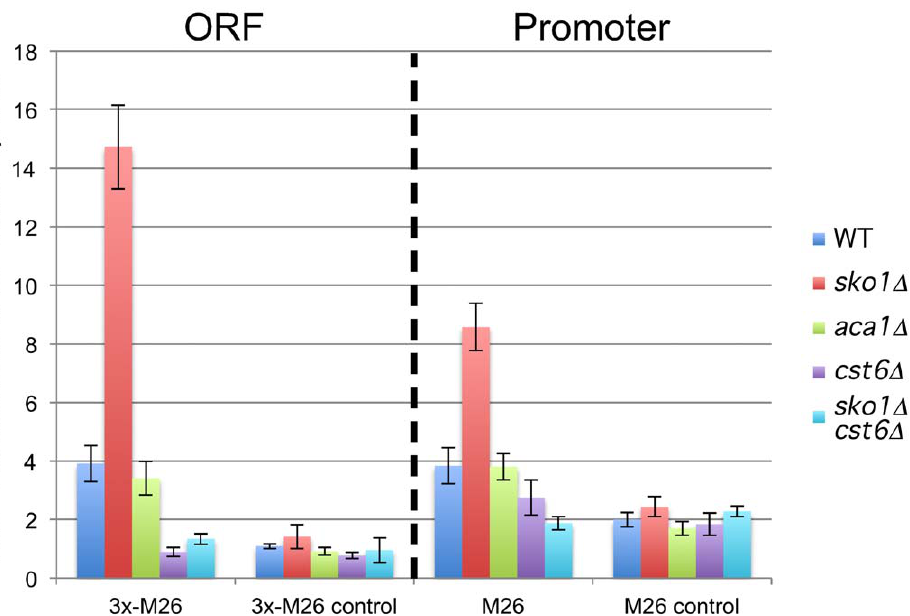
Figure 5. M26 hotspot is repressed by Sko1 and activated by Cst6. Strains containing the ade2-1003 allele and indicated transcription factor deletions were crossed to strains containing the same transcription factor deletions and the following ade2 alleles: 3x- M26 ( ade2-1008 ; ORF), 3x- M26 control ( ade2-1030 ; ORF), M26 ( ade2-1025 ; promoter), M26 control ( ade2-1026 ; promoter). Bars indicate the mean frequency of recombinants from at least three crosses. Error bars indicate one standard deviation. Transcription factor deletions are indicated by the format legend shown to the right. Crosses are from left to right: ( ade2-1008 6 ade2-1003 ) Wsc70 6 72, Wsc126 6 127, Wsc184 6 183, Wsc157 6 143, Wsc179 6 172; ( ade2-1030 6 ade2-1003 ): Wsc120 6 72, Wsc126 6 128, Wsc185 6 183, Wsc143 6 174, Wsc197 6 172; (ade2-1025 6 ade2-1003 ): Wsc115 6 72, Wsc126 6 129, Wsc186 6 183, Wsc143 6 144, Wsc172 6 173; M26 control ( ade2-1026 6 ade2-1003 ): Wsc116 6 72, Wsc126 6 130, Wsc187 6 183, Wsc143 6 145, Wsc200 6 172.